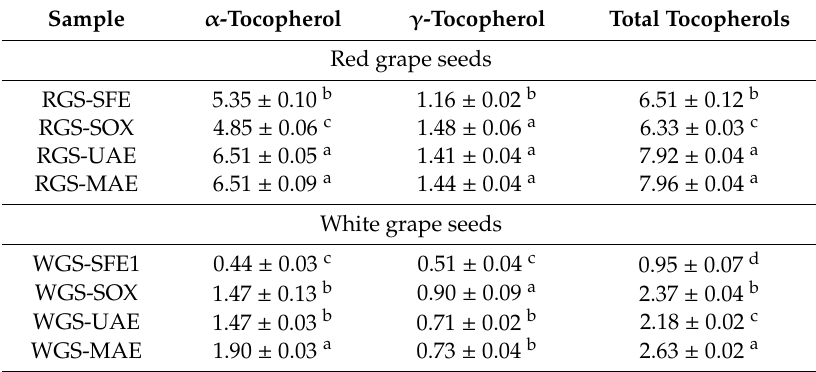
Table 5. Influence of extraction technique on tocopherols content in grape seed oil (mg 100 g − 1 ). Sample α -Tocopherol γ -Tocopherol Total Tocopherols Red grape